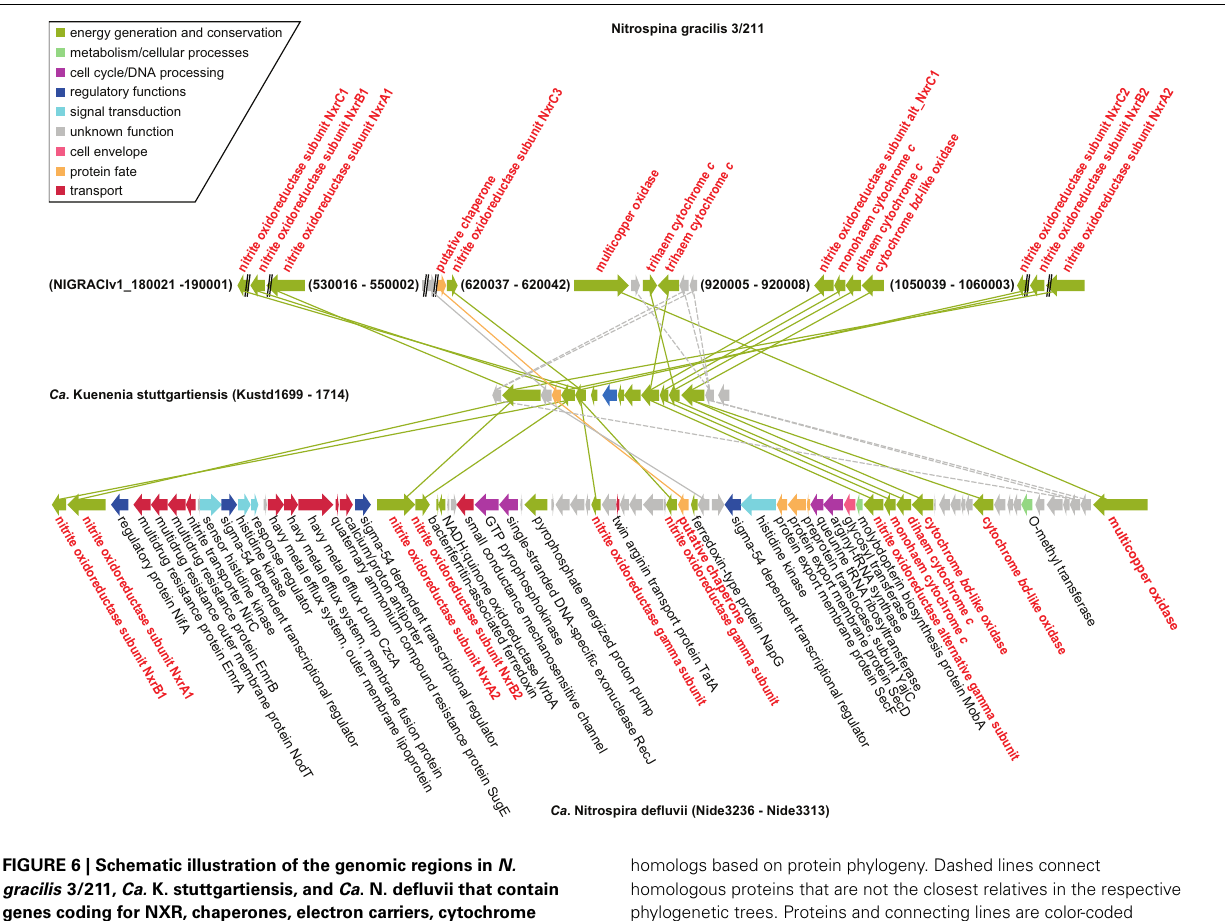
homologs based on protein phylogeny. Dashed lines connect homologous proteins that are not the closest relatives in the respective phylogenetic trees. Proteins and connecting lines are color-coded according to functional classes. CDS and intergenic regions are drawn to